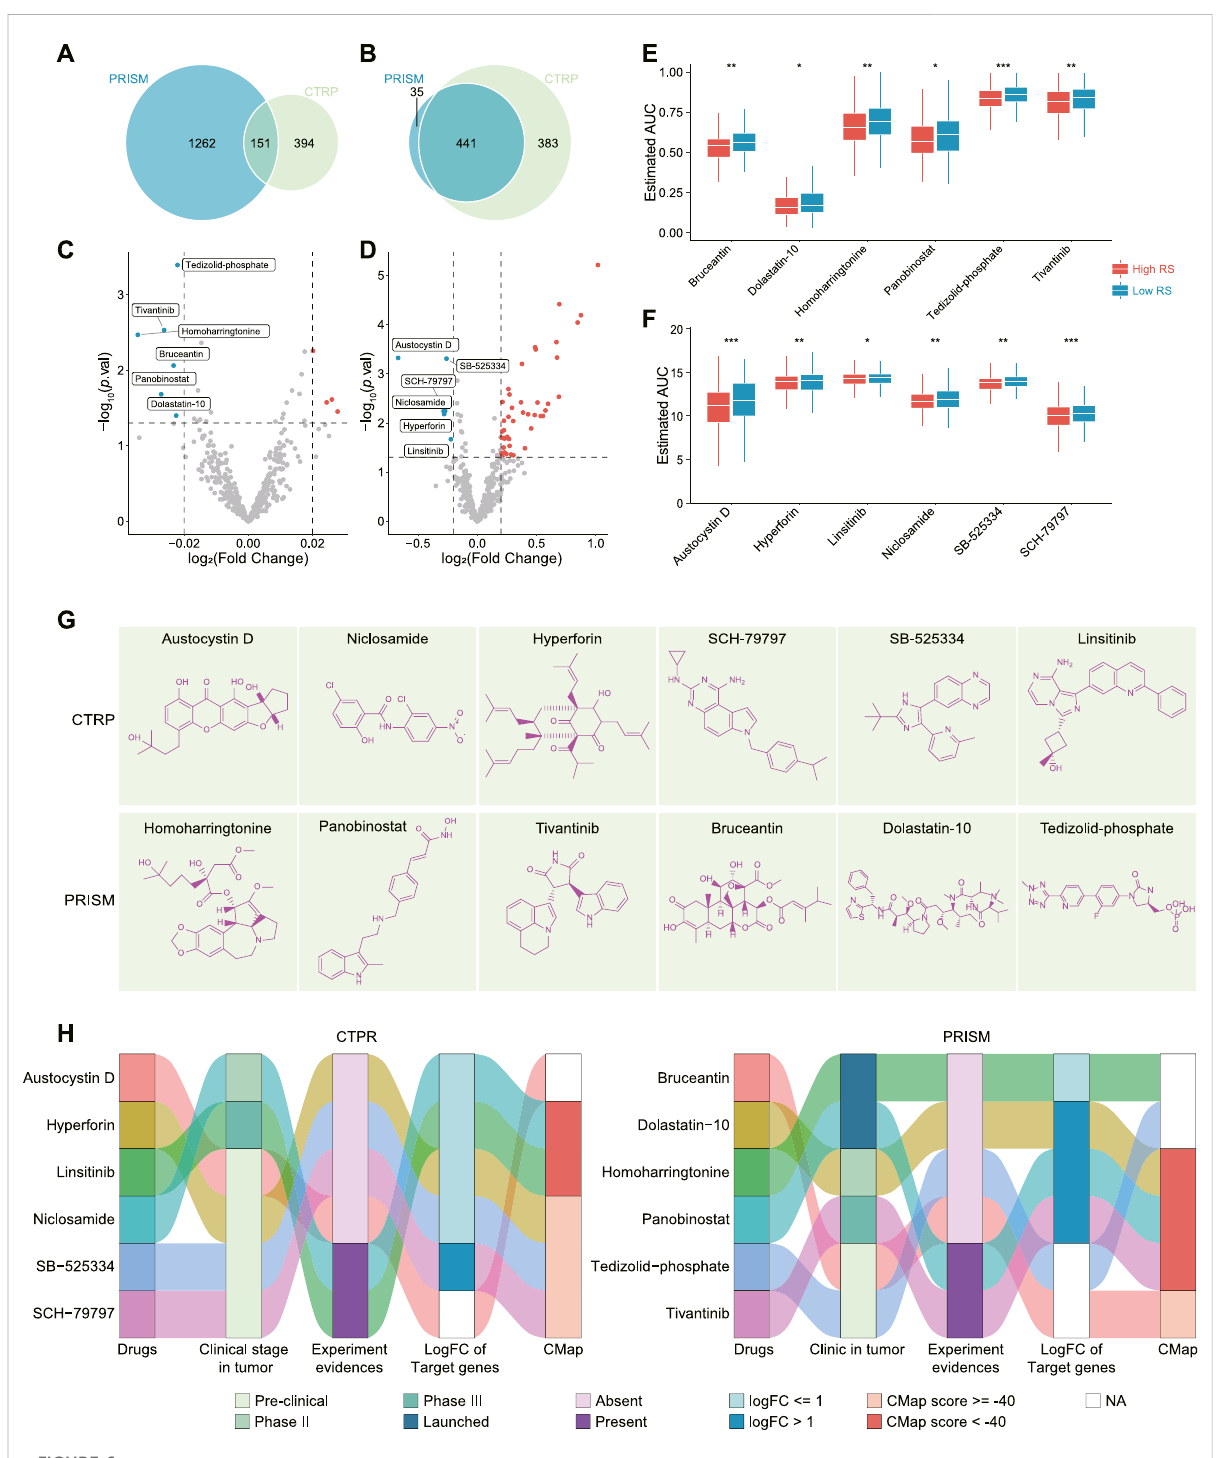
FIGURE 6 Comprehensiveanalysisofthesecandidate drugs. (A,B) Vennplotshowedthedrugs (A) andcelllines (B) includedinPRISMandCTRPdatabase. (C,D) Volcano plot displayed the drugs ’ differential AUC values between low and high RS groups in PRISM (C) and CTRP (D) database. (E) AUC values of Homoharringtonine, Panobinostat, Tivantinib, Bruceantin, Dolastatin-10, and Tedizolid-phosphate between low and high RS groups. (F) AUC values of Austocystin D, Niclosamide, Hyperforin, SCH-79797, SB-525334, and Linsitinib between low and high RS groups. (G) Chemical structures of the twelve candidate drugs. (H) A comprehensive analysis of the twelve candidate drugs from clinical and experimental evidences,